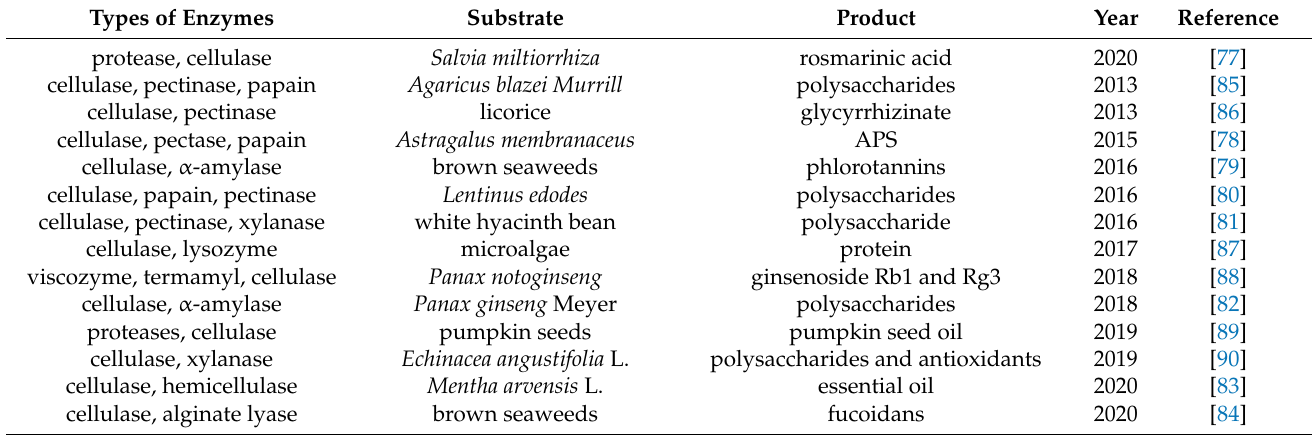
Table 6. Application of mixed enzymes (containing cellulase) in the extraction of bioactive ingredients. Types of